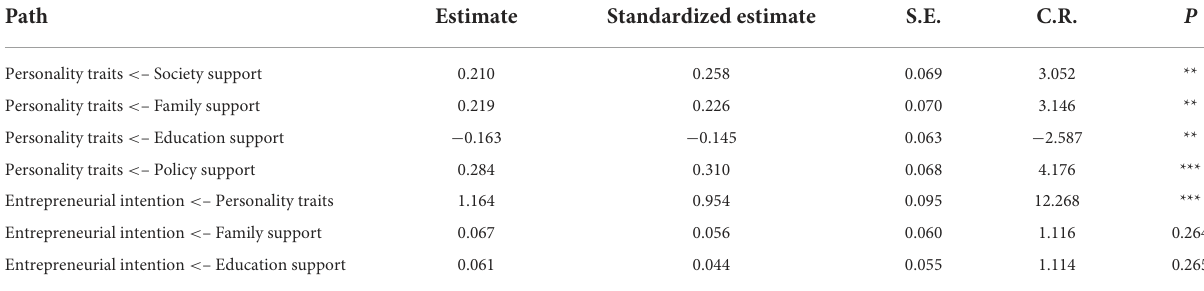
TABLE 4 Coefficients of the structural